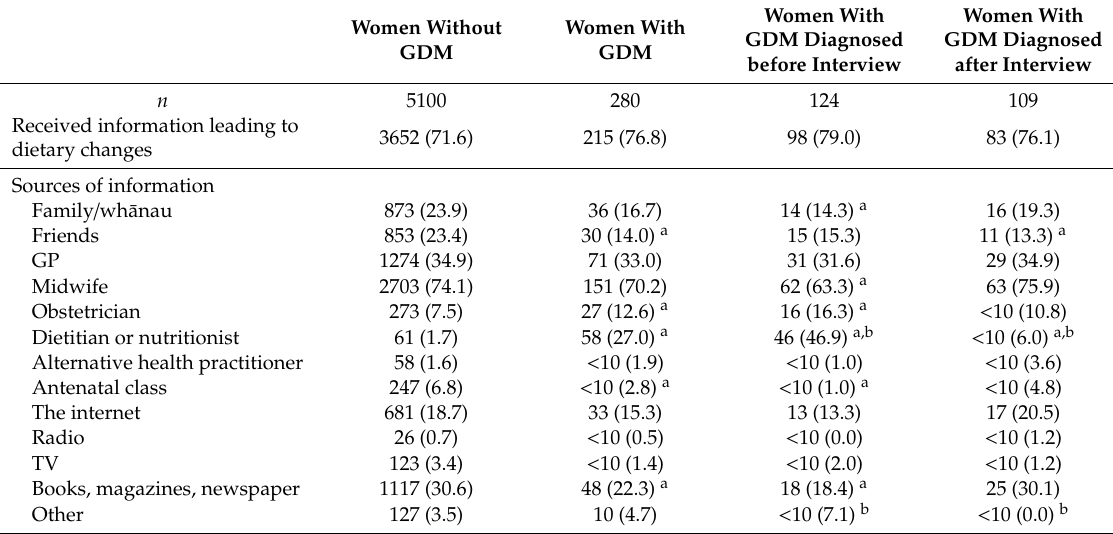
Table 6. Information leading to dietary